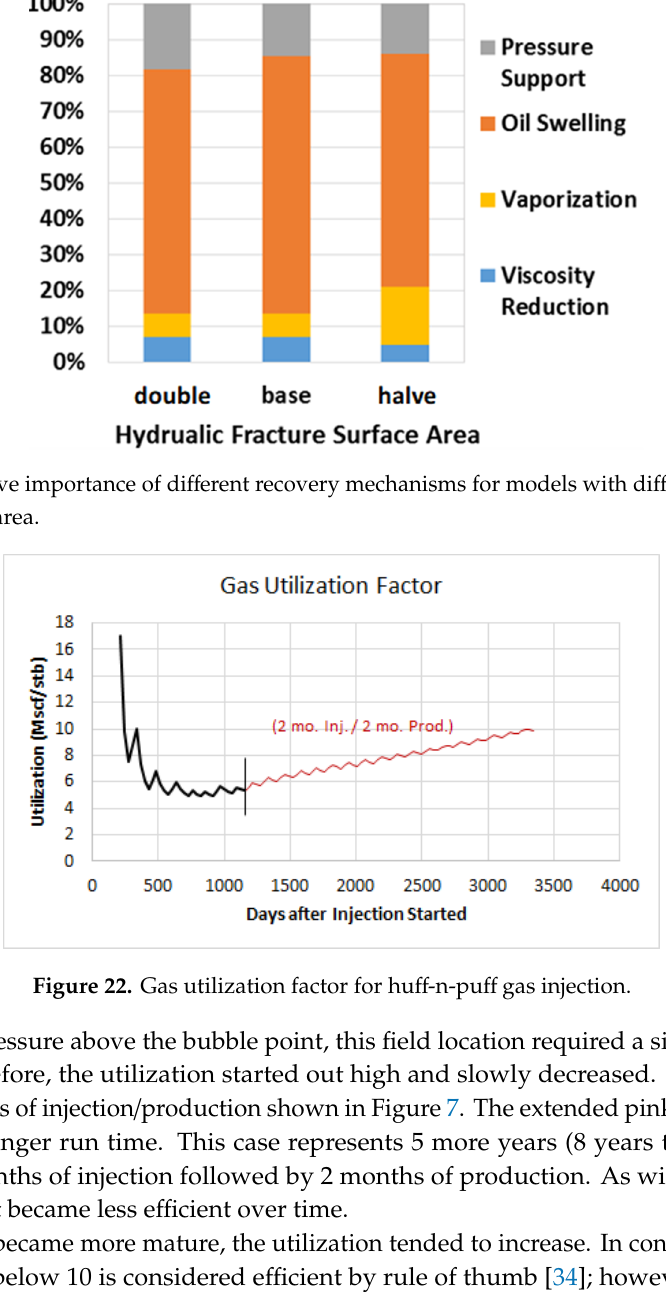
Figure 22. Gas utilization factor for huff-n-puff gas injection.